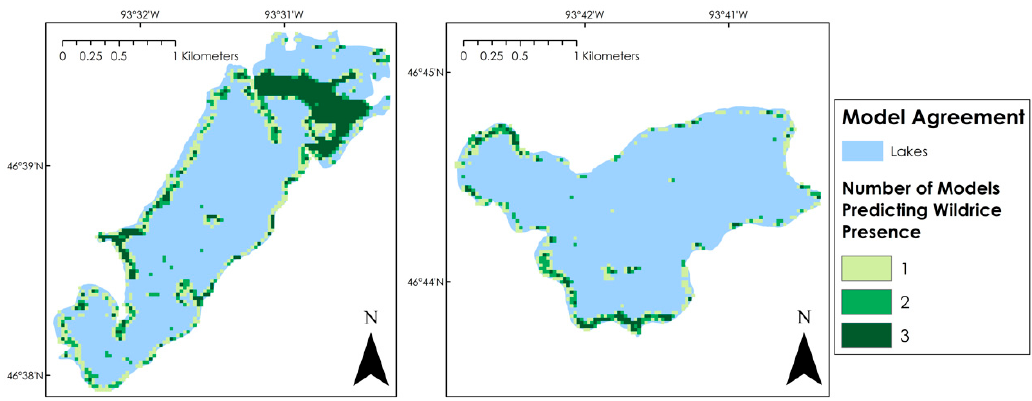
Figure 7. Agreement between model predictions of wildrice presence in 2015 across Gun Lake ( left ) and Esquagamah Lake ( right ).